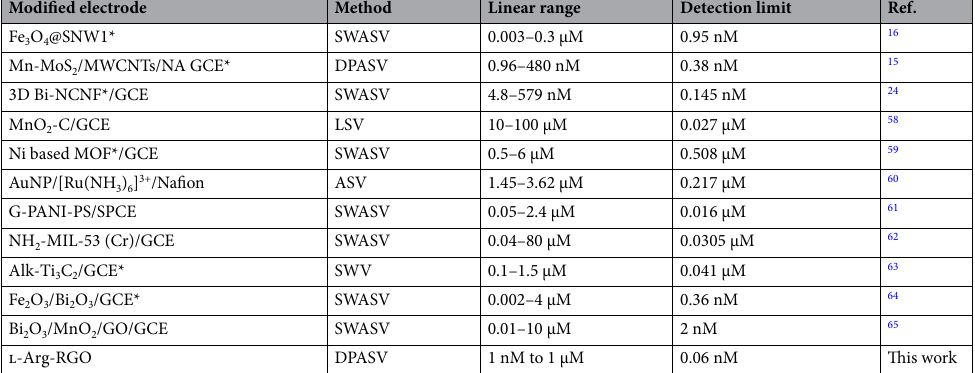
Table 1. Comparison analytical parameters of l-Arg-RGO/GCE with other modified electrodes as Pb(II) sensor. *Fe carbon nanosheet framework decorated with bismuth nanoparticles; MOF: Metal–organic framework; Alk-